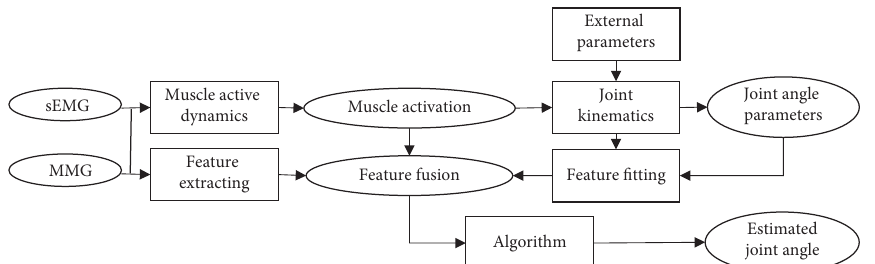
Figure 1: Structure of the sEMG-MMG state-space model. (1) The sEMG and MMG signals to the joint forward dynamics, (2) the fusion of sEMG and MMG features, and (3) the prediction algorithm.